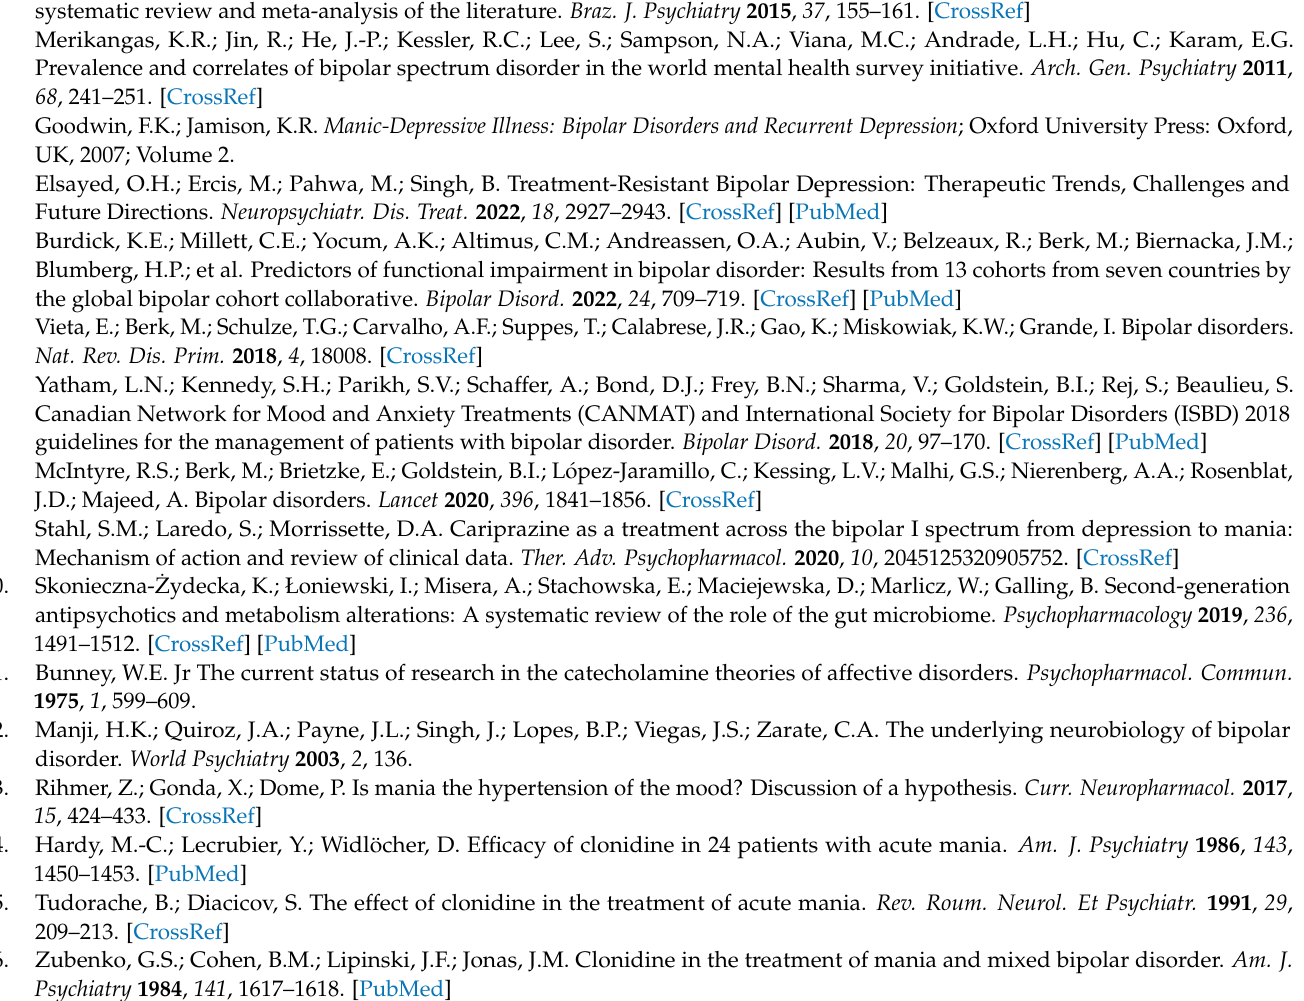
Table S2: (A) Risk of bias for RCTs; (B) Quality assessment of the non-randomized